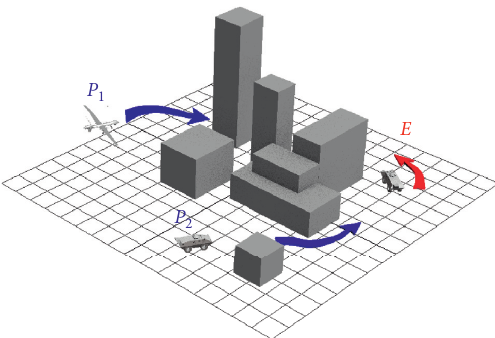
Figure 2: Collaborative pursuit-evasion game in complex 3D polygonal